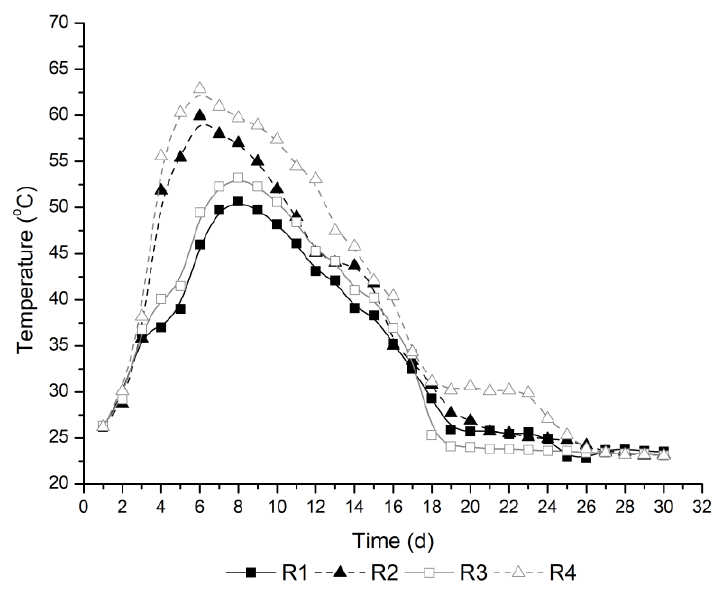
Figure 3. Thermal profile of the composting process in the bioreactors.